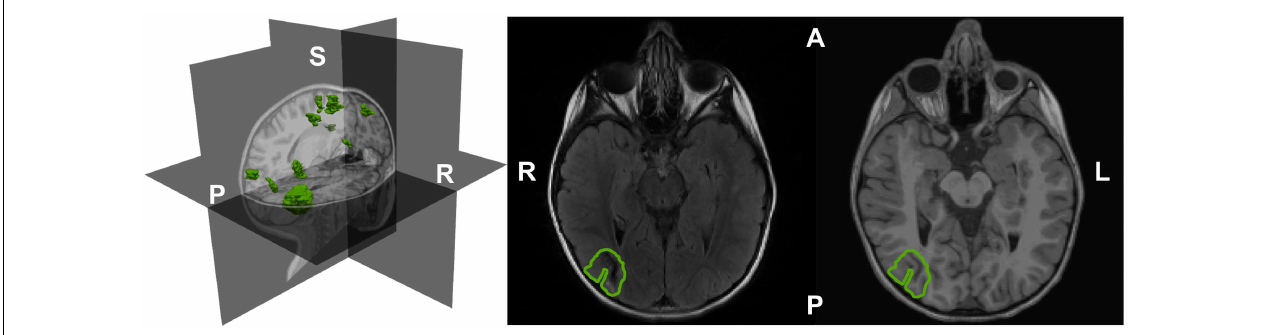
FIGURE 2 |The segmented and rendered tubers (in green) of the epilepsyTSC patient shown in a 3D head representation based onT1-weighted MRI data (left) .Tuber outline axial onT2 (center) andT1-weighted MRI images (right). A: anterior; L: left; P: posterior; R: right; S: